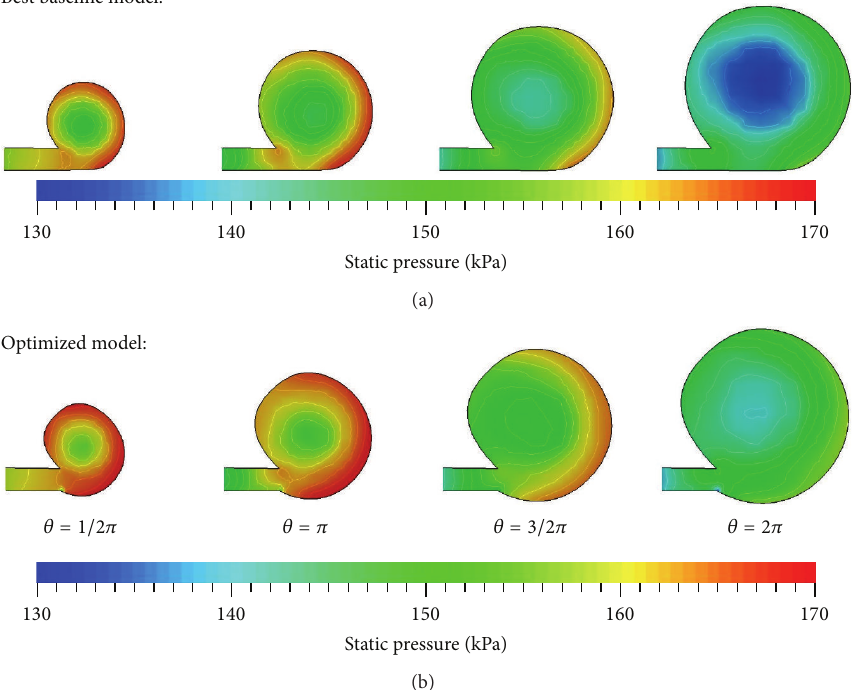
Figure 17: Static pressure at various azimuthal angles 𝜙 for the best baseline model (a) and optimized volute geometry (b) at ̇𝑚 corr = 0.19 kg/s. Best baseline model